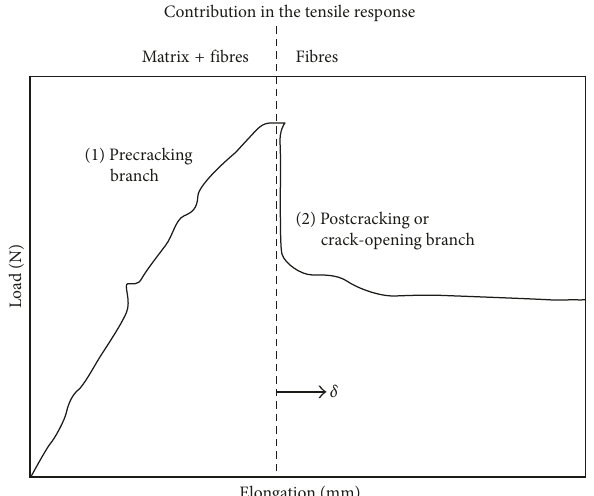
Figure 3: General response of concrete under direct tension